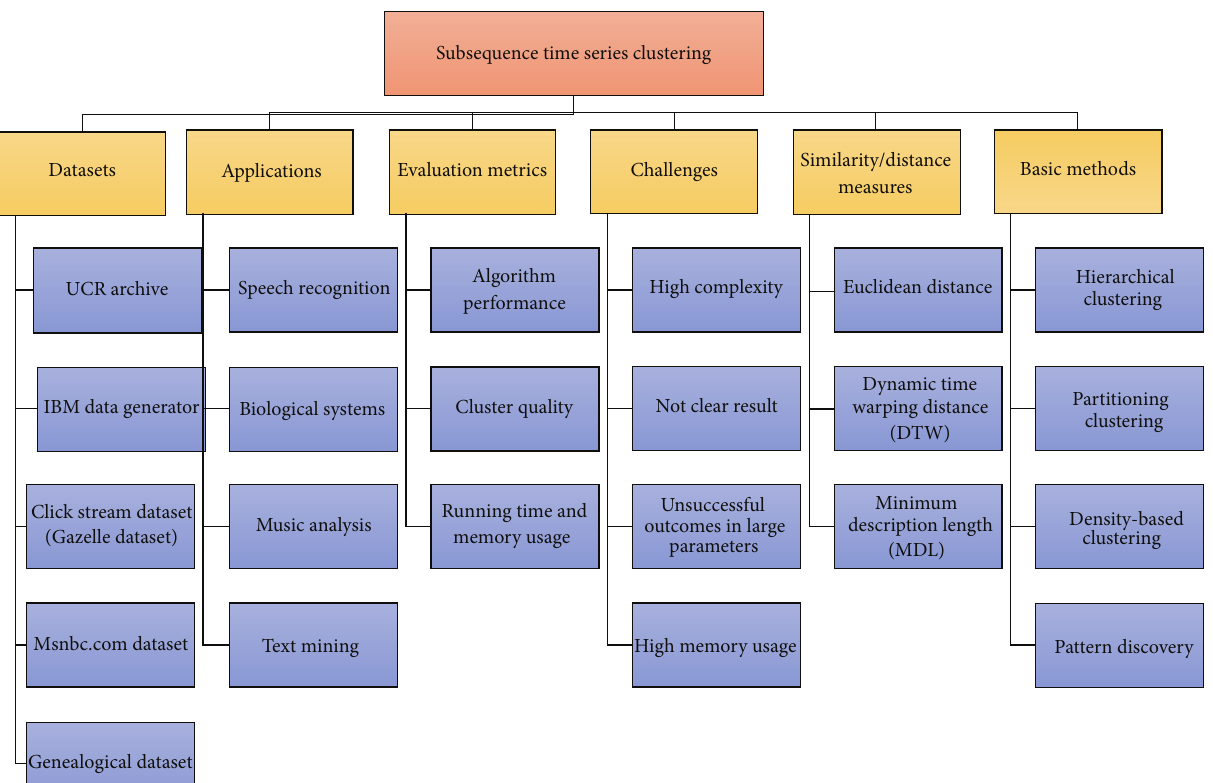
Figure 4: The general skeleton of subsequence time series